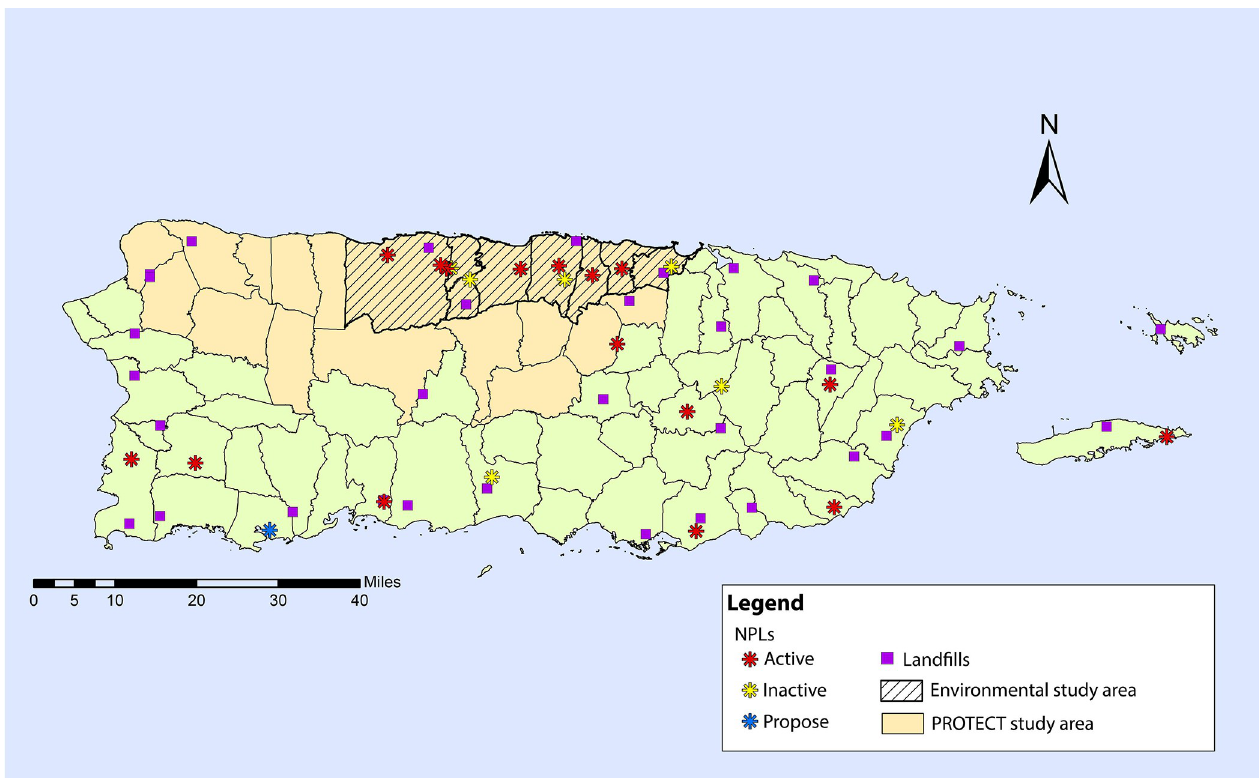
Fig 2. Map of Puerto Rico National Priority List of Superfund Sites and research area covered by the PROTECT Center.